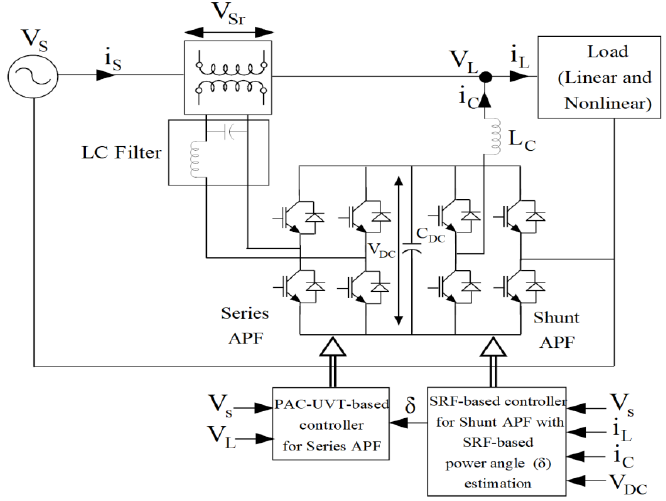
Figure 1. Single ‐ phase UPC system with equal reactive power sharing approach. Figure 1. Single-phase UPC system with equal reactive power sharing